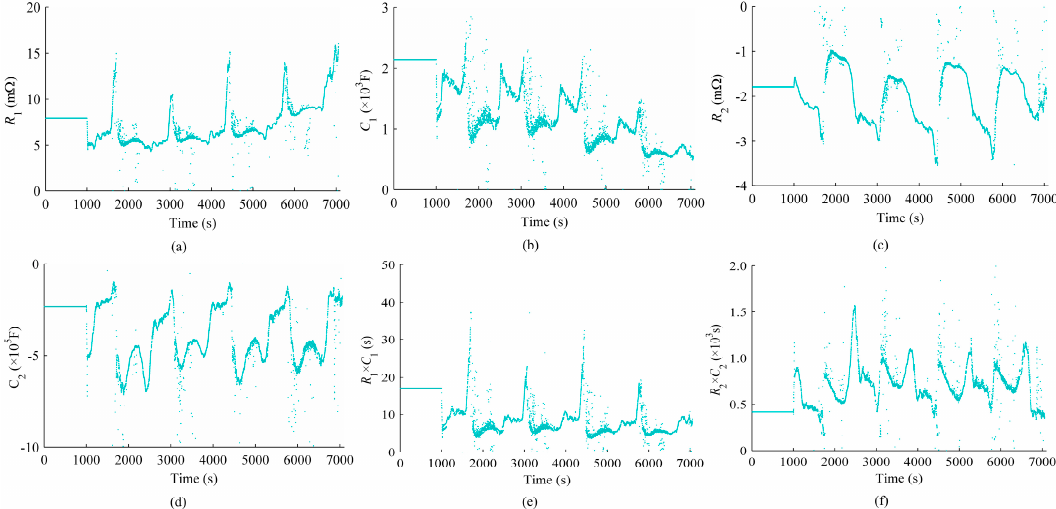
Figure 15. Identified ( a ) R 1 ; ( b ) C 1 ; ( c ) R 2 ; ( d ) C 2 ; ( e ) R 1 ˆ C 1 and ( f ) R 2 ˆ C 2 under